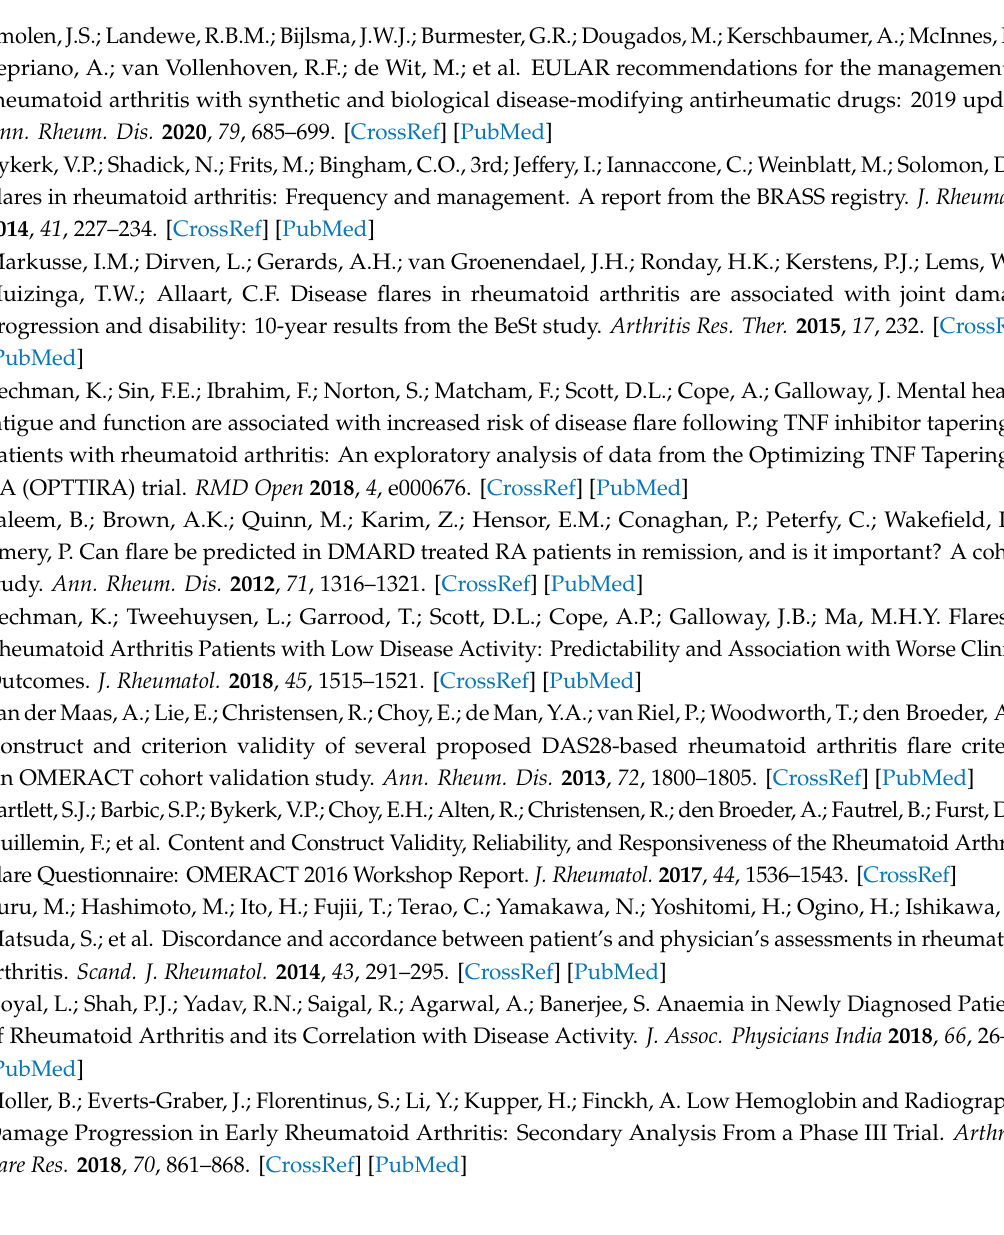
Table S1: Baseline characteristics of first year and second year flare groups, Table S2: Cox proportional hazards model of flares in patients with RA who exhibit